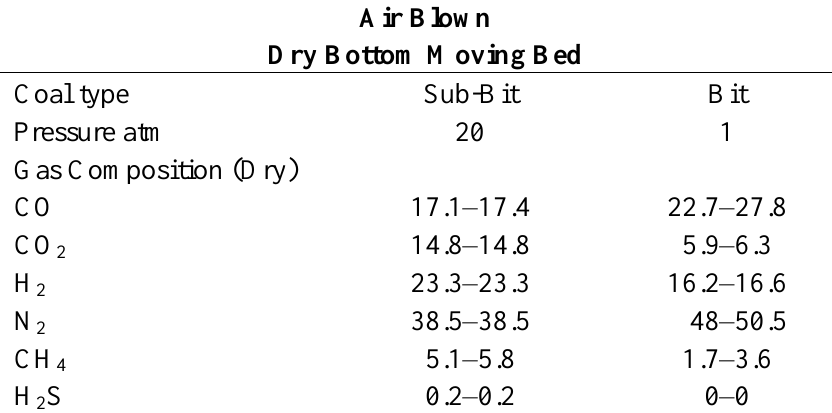
Table 5. Typical product compositions for Air blown moving bed gasifiers [8,10].